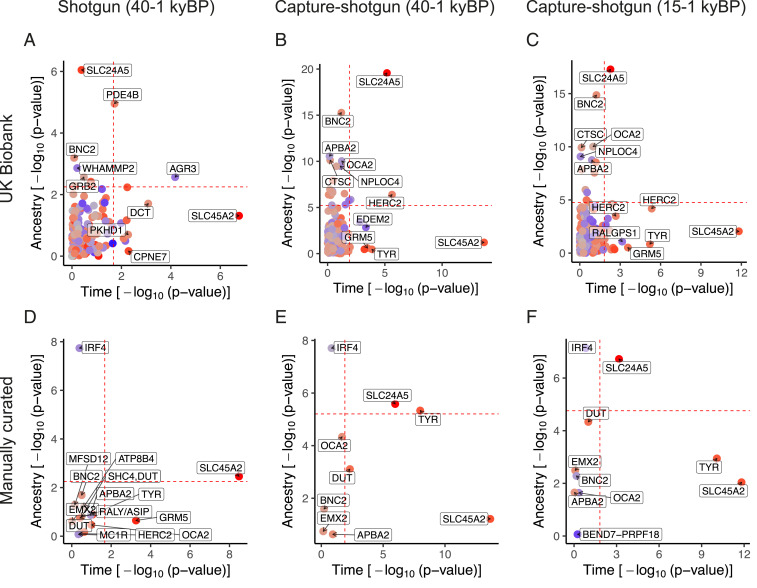
Plot of P values for ancestry and time for individual skin pigmentation SNPs. The dashed lines indicate fifth percentile of P values. UK Biobank SNPs using the shotgun dataset are plotted in A and capture-shotgun dataset in B and C. Manually curated SNPs using the shotgun dataset are plotted in D and capture-shotgun dataset in E and F. SNPs are colored according to whether the light allele is increasing over time (red) or decreasing (blue), with saturation determined by the magnitude of change.